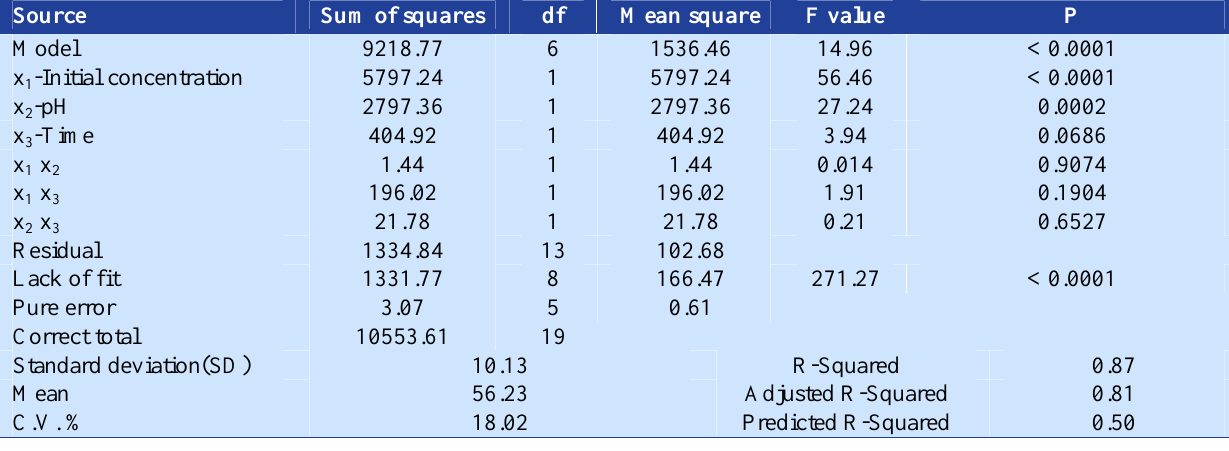
Table 2. ANOVA for humic substances degradation response surface